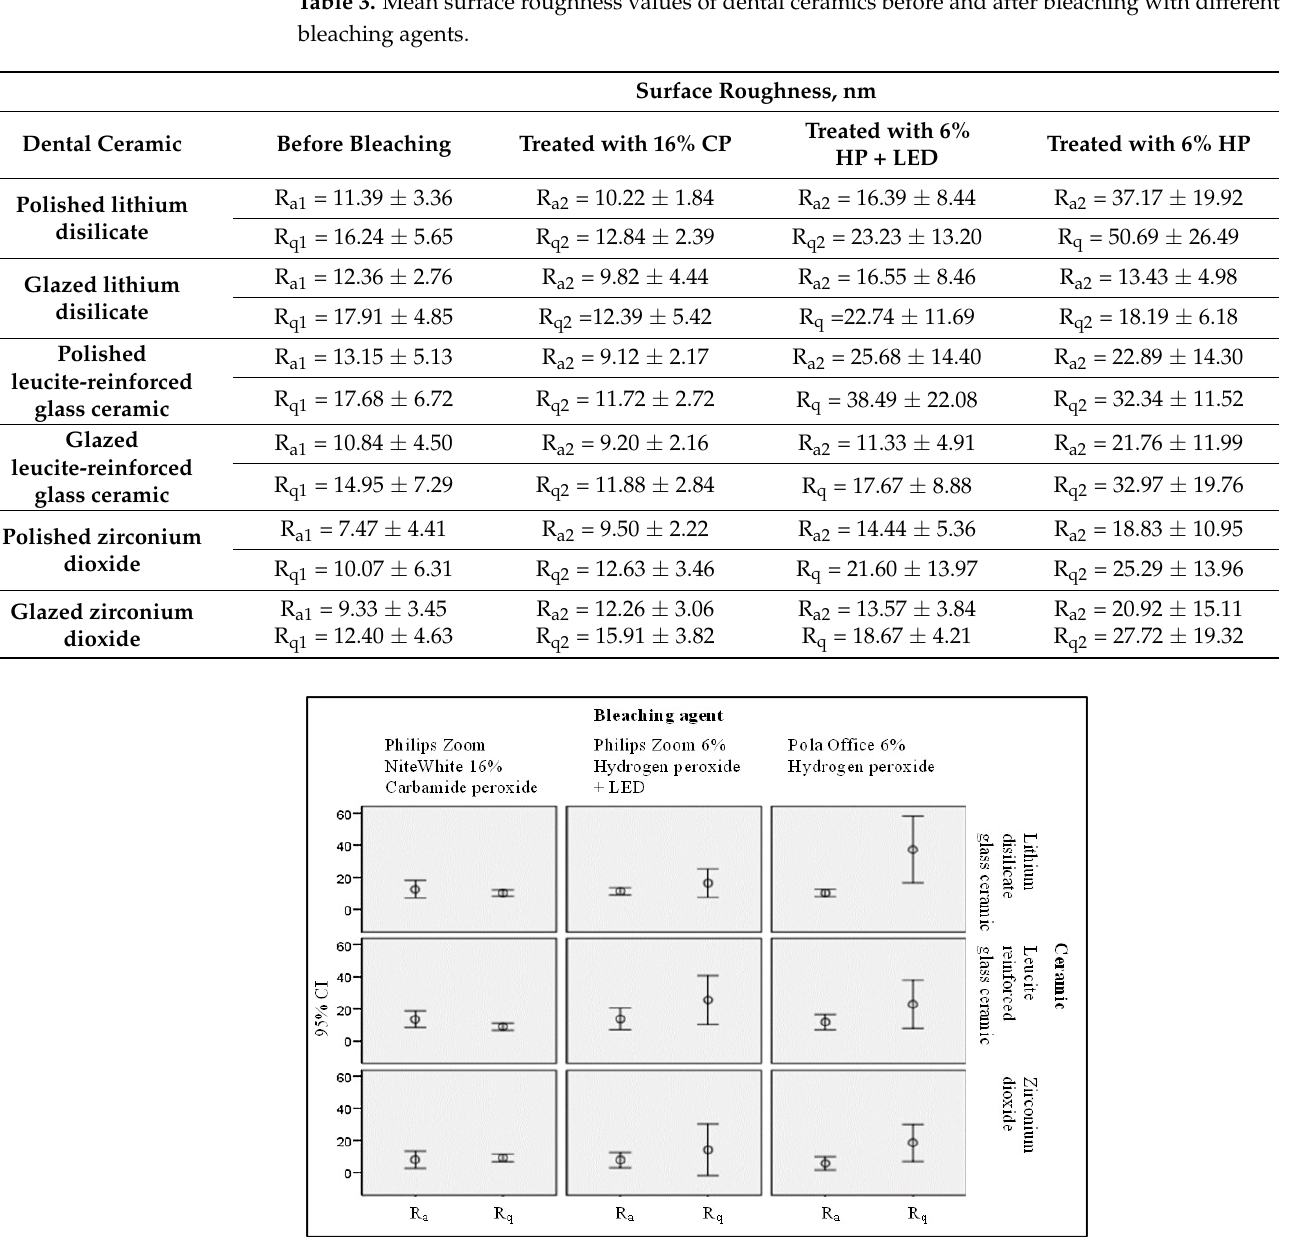
Figure 2. Statistical evaluation of the bleaching agent impact on the polished surface roughness of the treated ceramic samples.